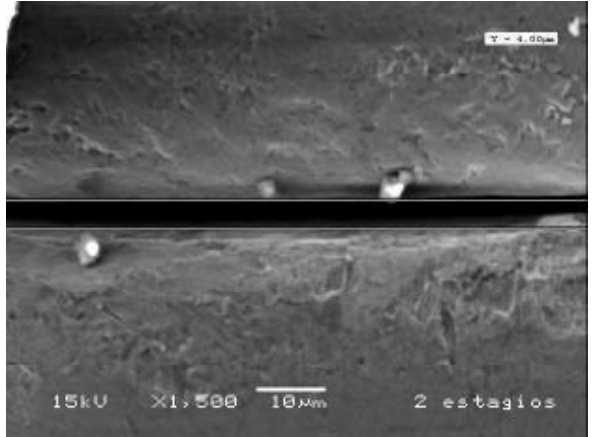
FIGURA 12- Determinação da extensão da fenda (seta) no sistema de dois estágios (x1500)